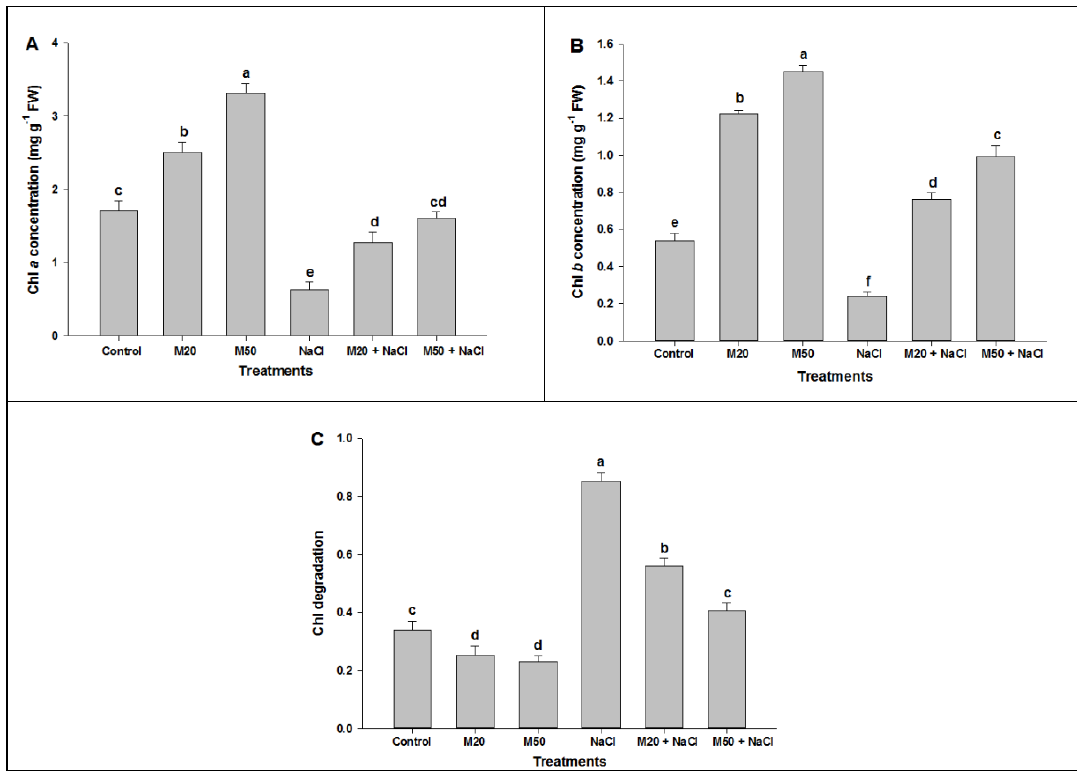
Figure 2. Effect of melatonin on ( A ) Chl a , ( B ) Chl b and ( C ) Chl degradation in leaves of tomato seedlings under salinity. Data represent mean of 4 replicates with bars indicating SE. The bars labelled with different letters are significantly different at p < 0.05%. [DDW (control), 20 µM melatonin (M20), 50 µM melatonin (M50), 100 mM NaCl (NaCl)].